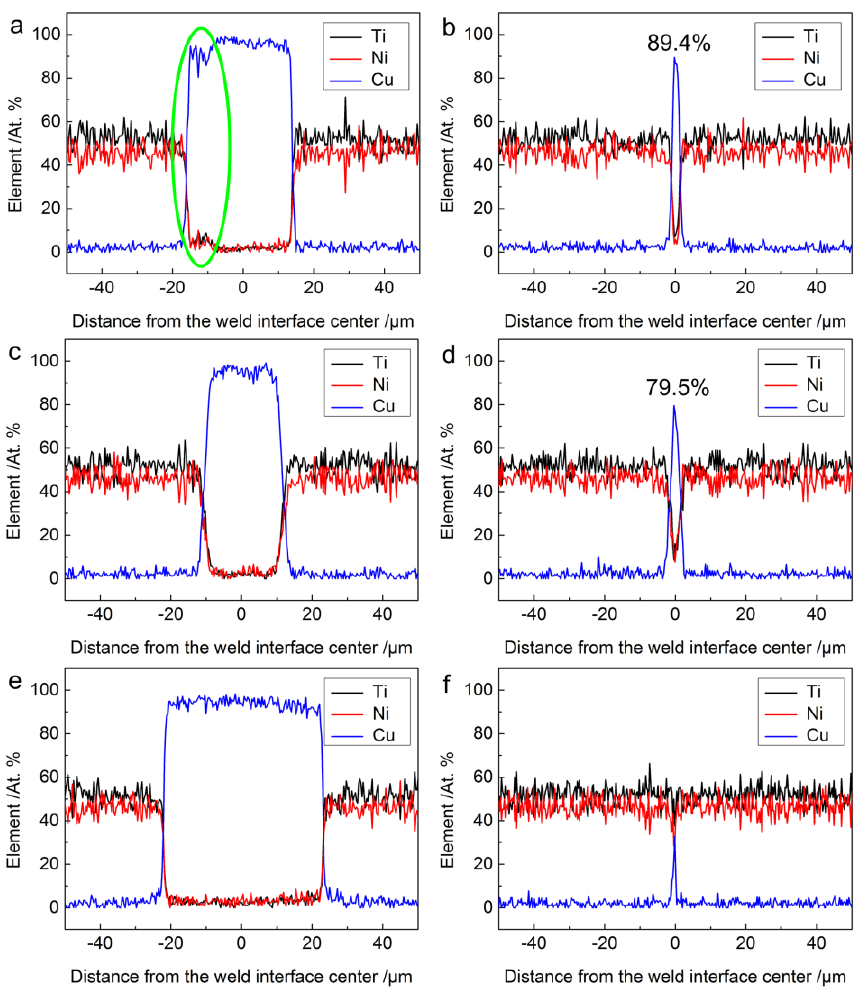
Figure 5. Chemical composition across the weld interface of NiTi joints with Cu interlayer: ( a , b ) 500 J; ( c , d ) 700 J; ( e , f ) 1000 J. The positions where the EDS line scans were performed are indicated by the white lines in Figure 4 ( a , c , e ).